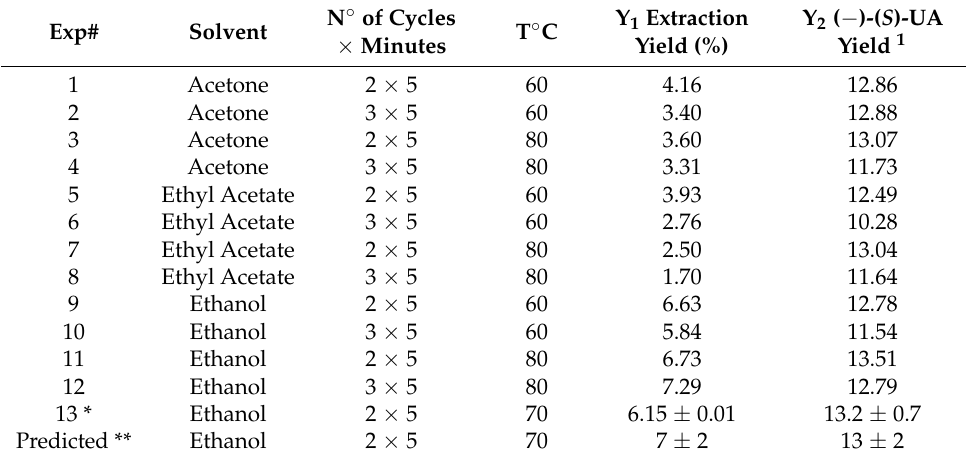
Table 1. Experimental plan and response